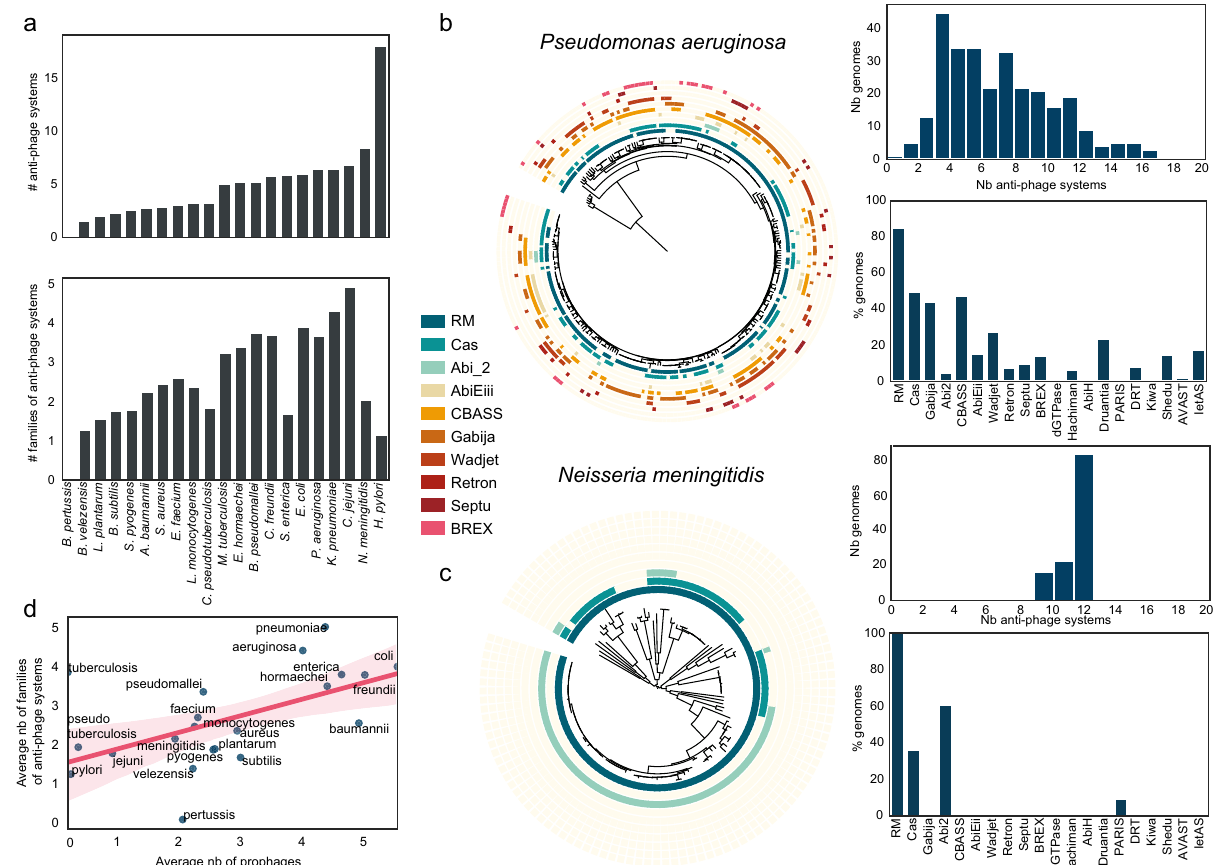
Fig. 4 The antiviral arsenal is species speci fi c. a Number of systems and number of families of systems per species. Species with more than a hundred genomes were selected for this analysis. b , c Antiviral arsenal of two different species: Pseudomonas aeruginosa and Neisseria meningitidis . Each panel shows the distribution of the total number of systems in the species (top panel), the frequency of the 20 most common antiviral systems in prokaryotes in this species (bottom panel) and a phylogenetic tree of the species with the presence/absence of the 10 most common antiviral systems in prokaryotes. d Correlation at the species level between the number of prophages and the families of antiviral systems (linear regression, two sided Pearson r = 0.56, p -value = 0.008, light pink represents the con fi dence interval at